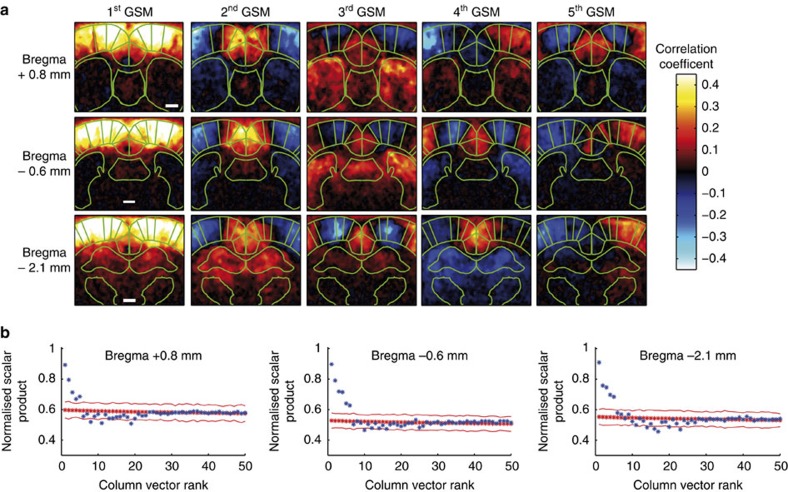
Anticorrelated fUS connectivity patterns reveal distinct functional networks at three different coronal planes.(a) Global spatial modes (GSMs), representing reproducible connectivity patterns (N=6), at the three investigated coronal levels. The first GSMs show synchronized haemodynamic fluctuations in the cortical ribbon, which did not include the secondary anterior cingulate cortex (see Figs 2 and 5 for anatomical definitions). Subsequent GSMs delineate highly contrasting cortical connectivity patterns, where the midline anterior cingulate and retrosplenial cortices (red and yellow on GSM 2 and 3), prominent hubs of the putative default-mode network are temporally anticorrelated with the task-dependent lateral sensorimotor network (blue and light blue on GSM 2 and 3, respectively). These two main cortical networks are also correlated with subcortical regions such as the caudate, putamen and septum. Scale bar, 1 mm. (b) Results of the thresholding procedure, as described in Methods. Blue dots: values from the GSMs with noise removed. Red dots: simulated Gaussian random noise. Plain red line: 2 × the s.d. of mean noise. GSMs with a value higher than this level were considered significantly different from the noise.